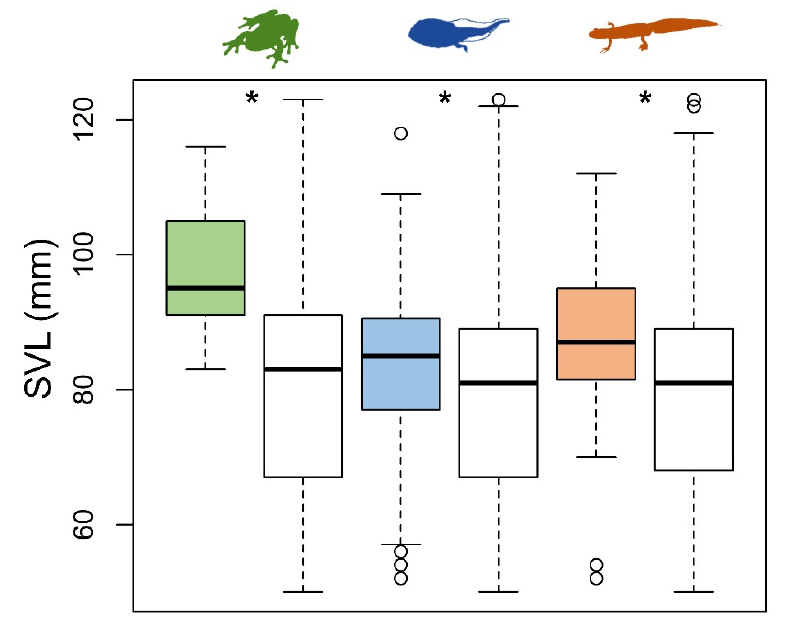
Figure 4. Size (snout-vent length, in mm) of marsh frogs that consumed amphibians (colored bars) and those that did not consume amphibians (clear bars). Green ( left ): metamorphosed anurans; blue (middle): tadpoles; orange ( right ): newts. Boxplots represent median (25–75%) ± 1.5 IQR. Open circles represent outliers. Asterisks indicate significant differences between groups (see text).